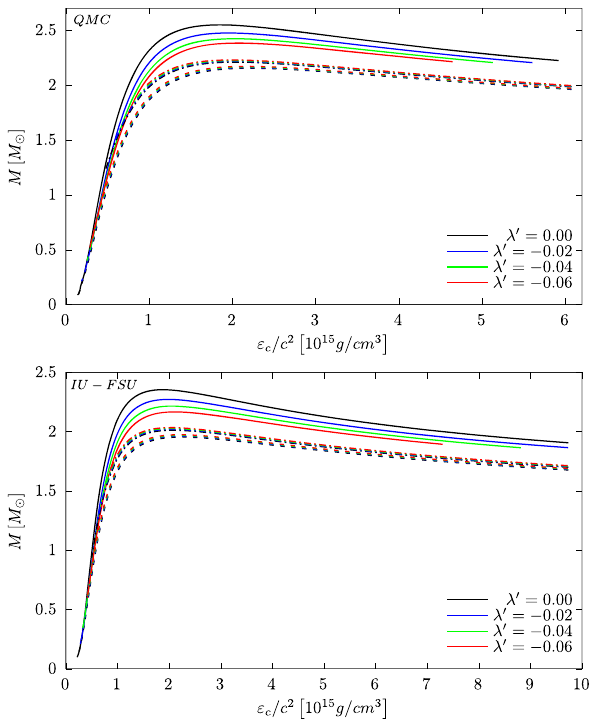
Fig. 3 The mass as a function of the central energy density for sequences of non-rotating stars (dashed curves), stars rotating at 716 Hz (dash-dot curves) and for stars rotating at the mass–shedding limit (solid line curves). The curves for λ (cid:6) = 0 correspond to the GR case